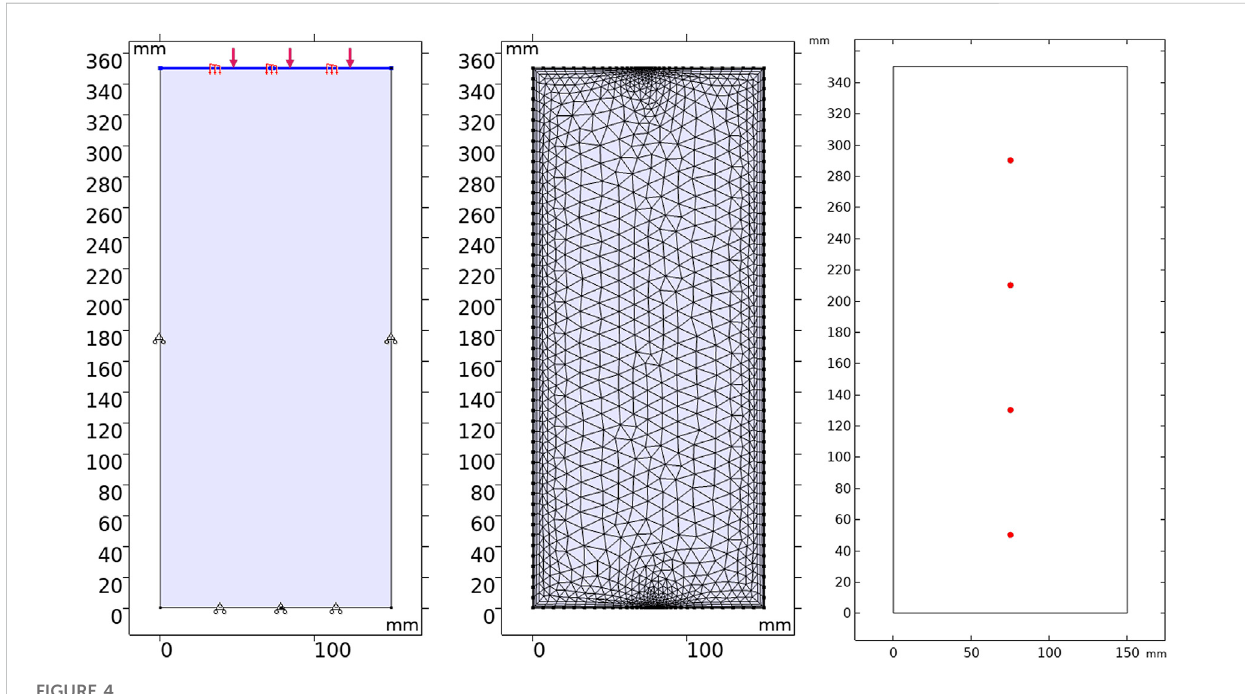
FIGURE 4 Geometric model and the selected measuring point position.